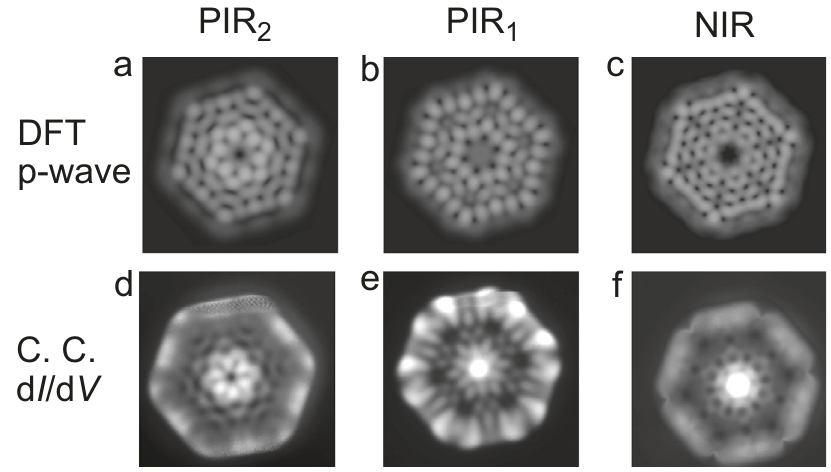
Fig. 3 Calculated gas-phase p-wave molecular orbitals and constant-current d I /d V maps of C108 obtained with a CO tip. a – c Visualization of the molecular wavefunctions as calculated by DFT using a p-wave tip at the resonance energies V PIR2 = − 1.52 V, V PIR1 = − 1.06 V, and V NIR = 1.8 V. d – f Constant-current d I /d V maps performed with CO tip at the bias voltages V PIR2 = − 1.47 V, V PIR1 = − 1.05 V, and V NIR = 2 V, and current setpoints of I = 5 nA, I = 3 nA and I = 50 nA, V = 10 mV. Image sizes are 2.5 × 2.5 nm 2 . PIR2 PIR1 NIR mod